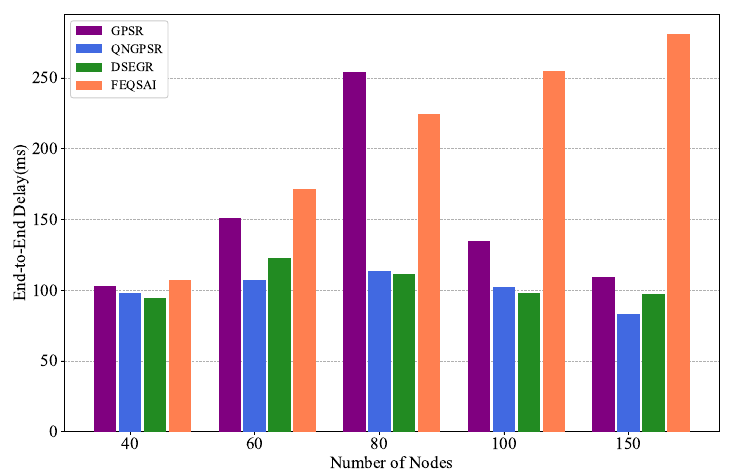
Figure 8. Performance comparison of the average E2E delay among GPSR, QNGPSR, DSEGR, and FEQSAI with different node densities.